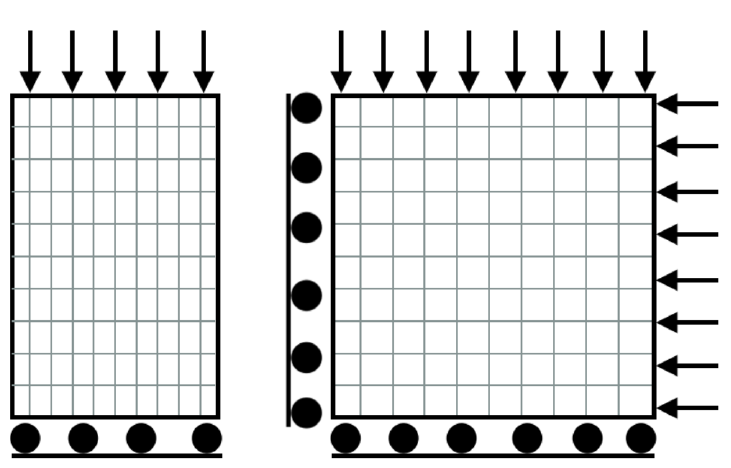
Figure 6. Finite element mesh and boundary condition for both tests, uniaxial ( left ) and equibiaxial ( right